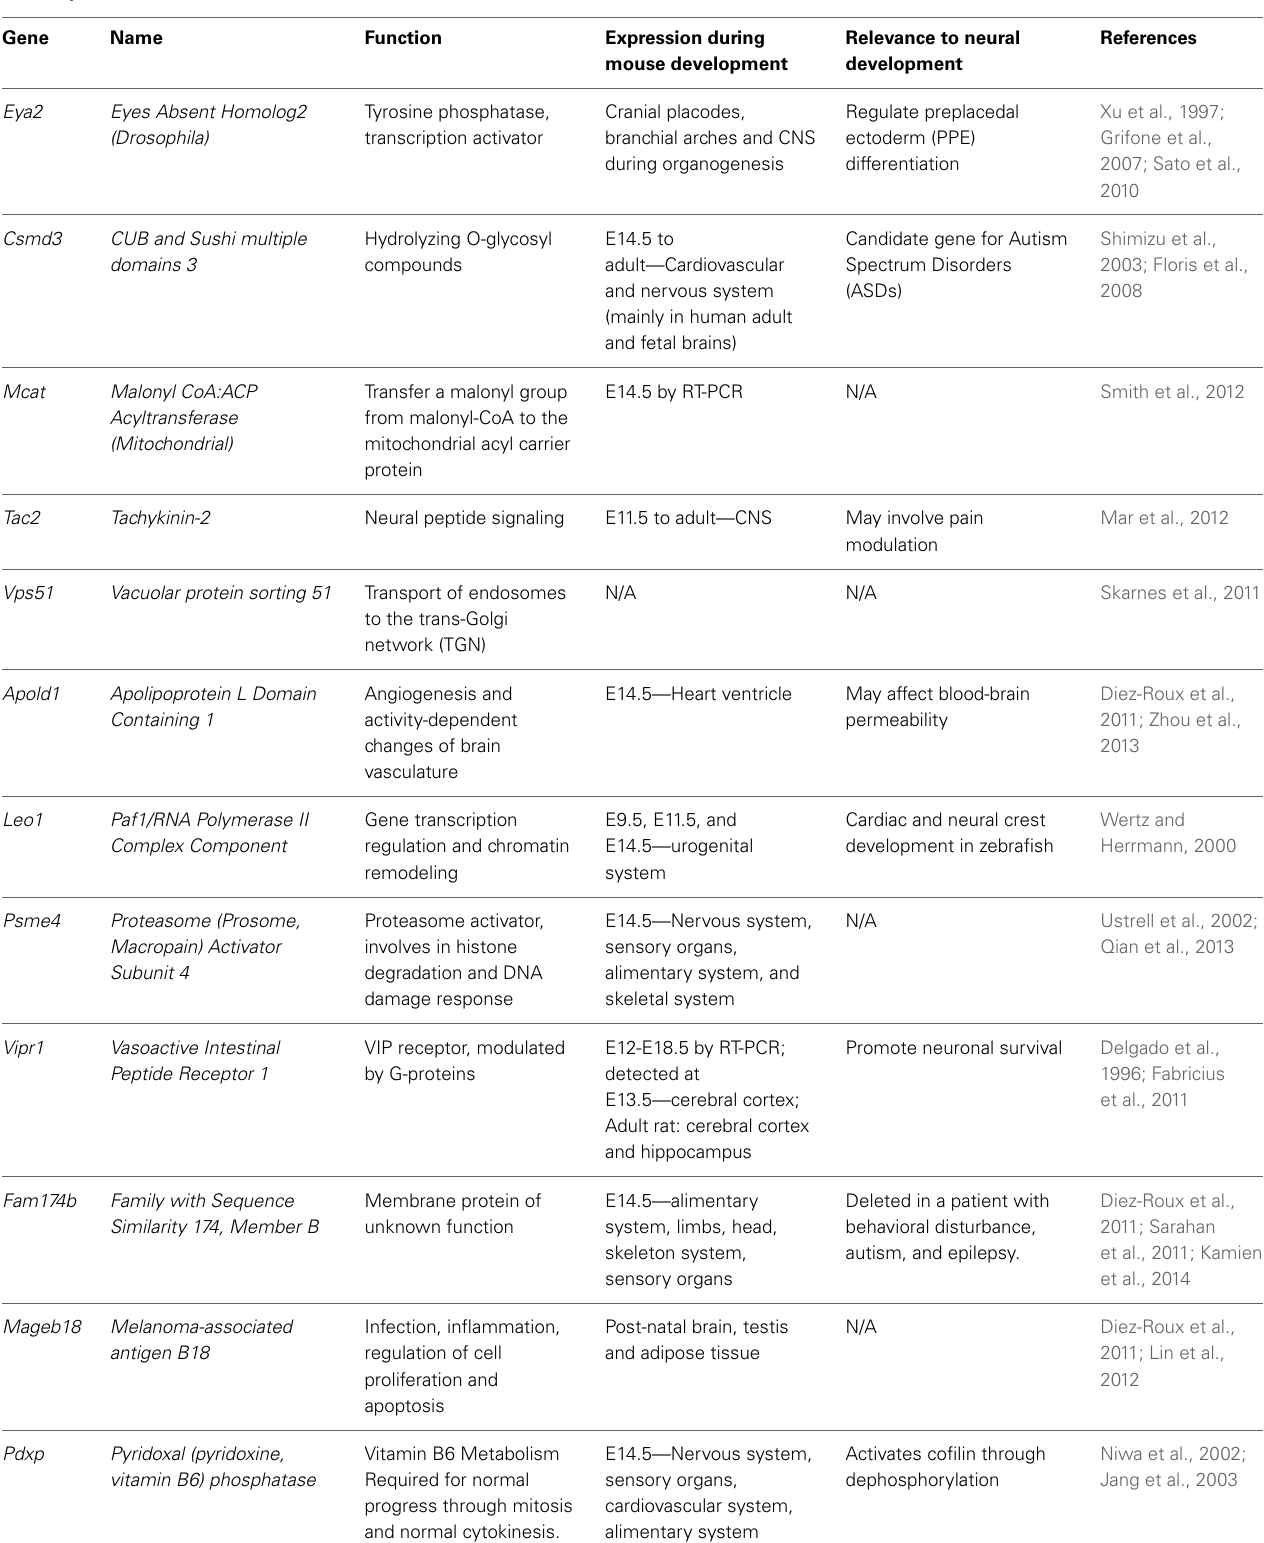
Table 2 | Genes Demonstrating a GxE Interaction with Associated SNVs in the